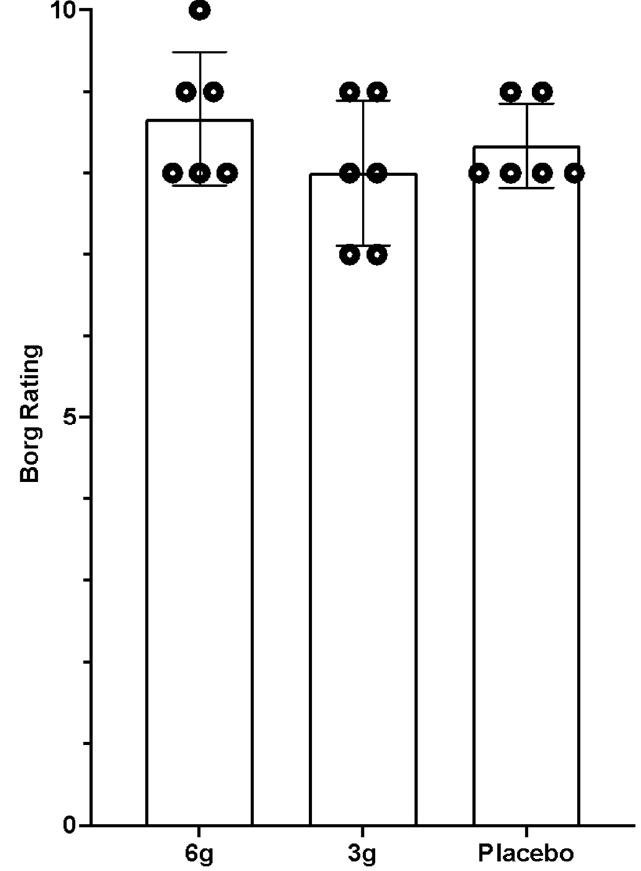
Figure 4. Rating of perceived exertion (Borg’s scale).